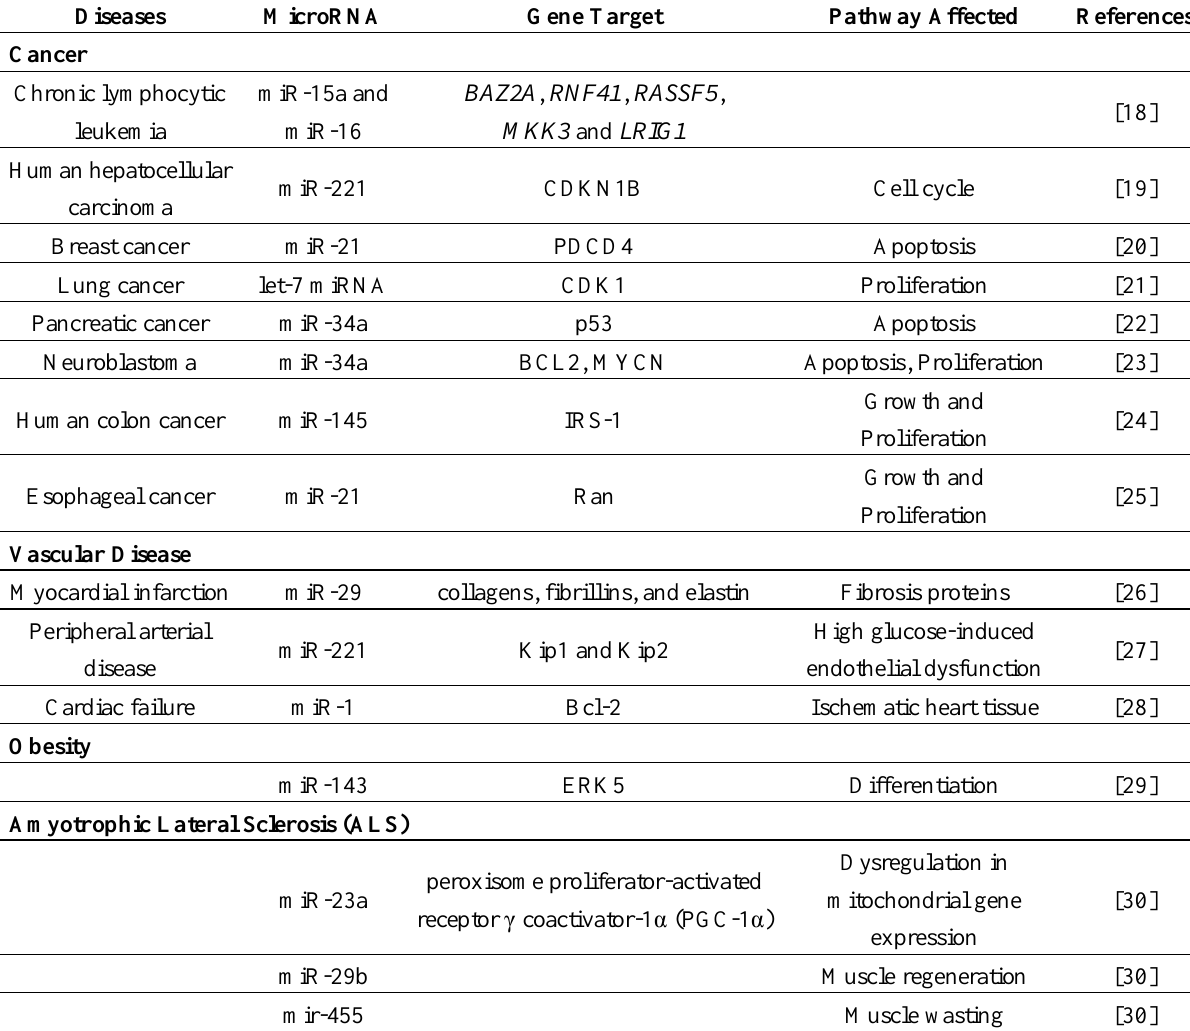
Table 1. Different miRNAs involved in a variety of diseases other than renal